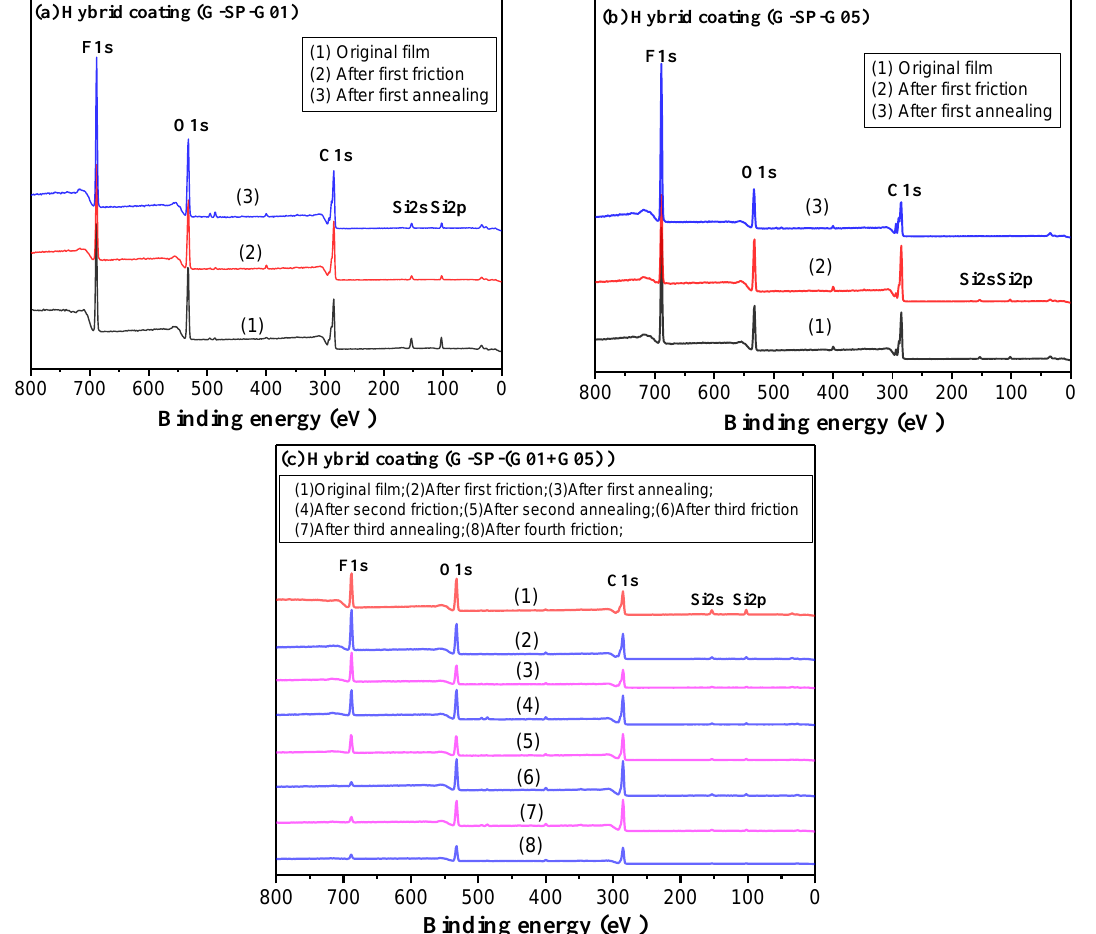
Figure 5. XPS traces of the three hybrid coatings during the friction-annealing treatment process: ( a ) hybrid coating with 2 wt.% G-SP-G01 addition; ( b ) hybrid coating with 2 wt.% G-SP-G05 addition; ( c ) hybrid coating with 2 wt.% G-SP-(G01+G05) addition.